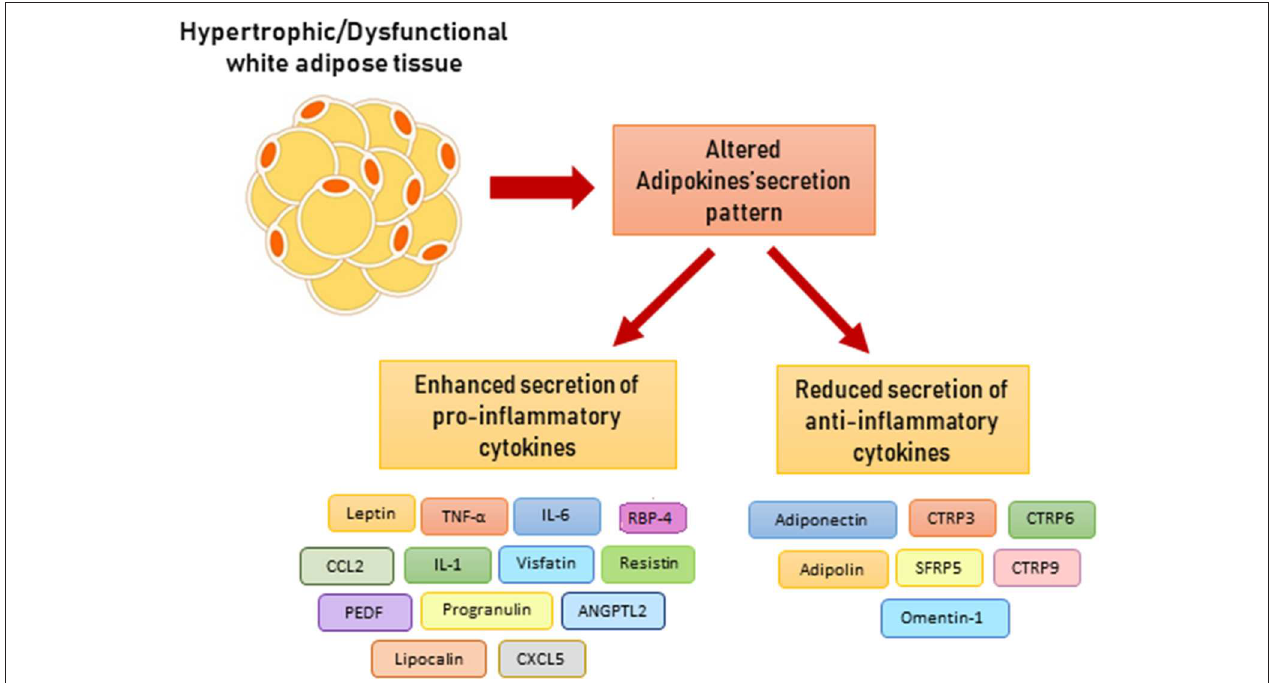
FIGURE 3 | Altered adipokine secretion pattern in dysfunctional adipose tissue. ANGPTL2, angiopoietin-like protein 2; CCL2, CC-chemokine ligand 2; CXCL5, CXC-chemokine ligand 5; CTRP, C1q/TNF-related protein-3; CTRP, C1q/TNF-related protein-6; CTRP, C1q/TNF-related protein-9; PEDF, pigment epithelium-derived factor; RBP-4, retinol binding protein 4; SFRP5, secreted frizzled related protein